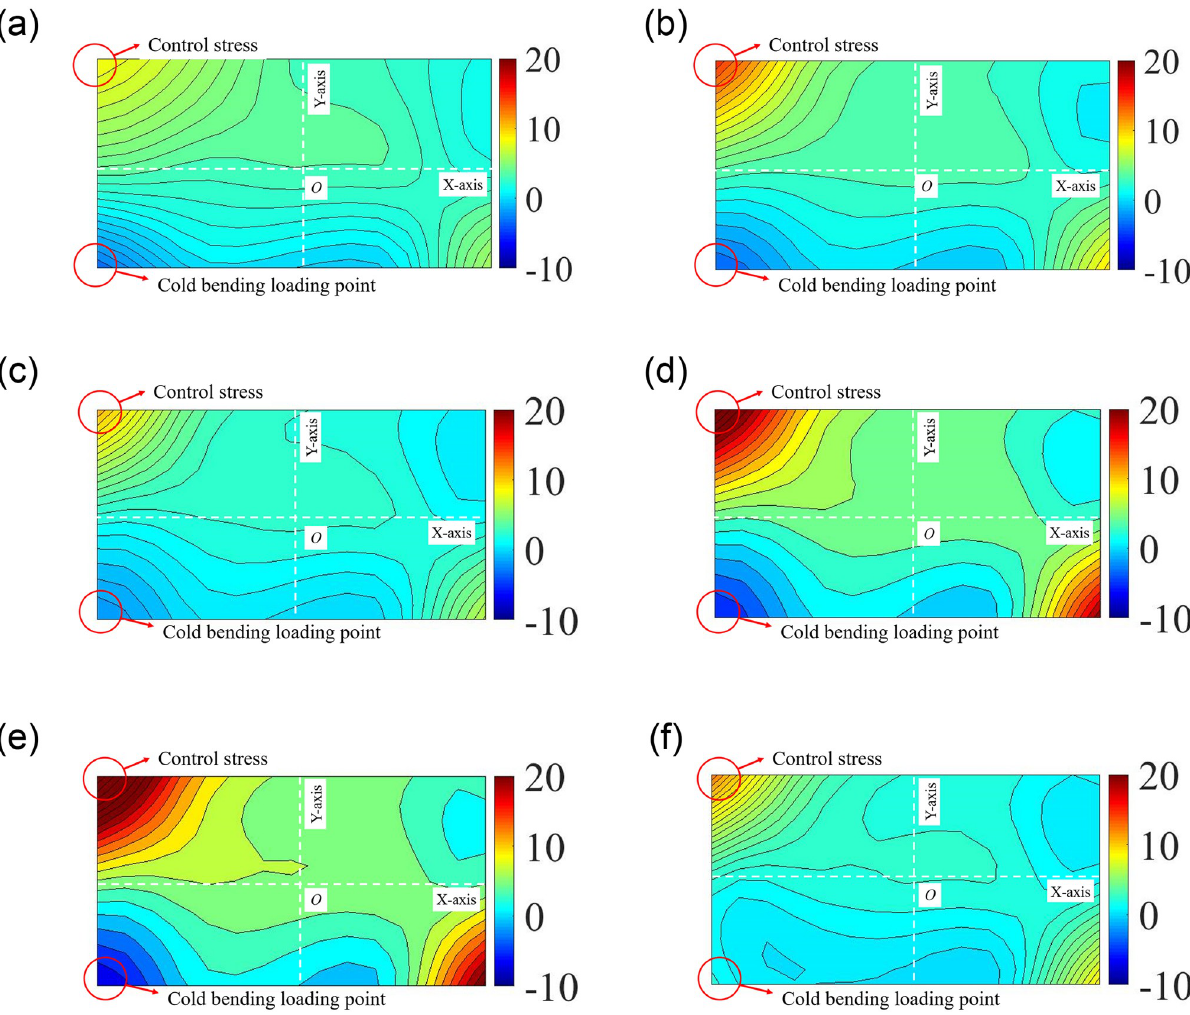
Fig 6. Cold bending stress nephograms on surface D-2 [MPa]. (a) SJ2; (b) SJ3; (c) SJ4; (d) SJ5; (e) SJ7; (f) SJ9.